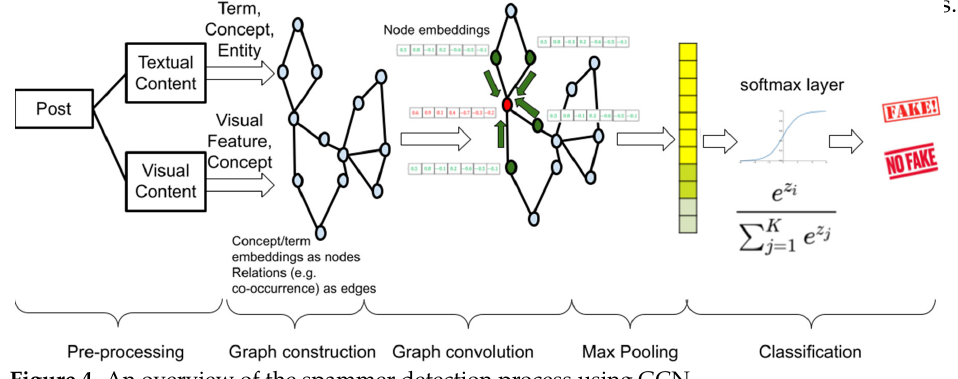
Figure 4. An overview of the spammer detection process using